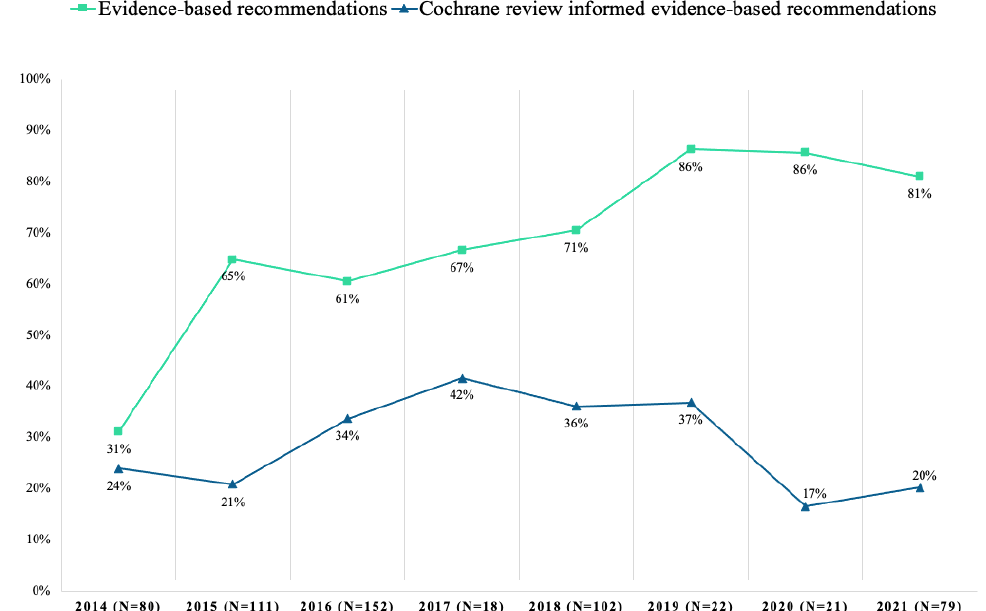
Figure 1. Evidence-based recommendations with outcomes informed by evidence from Cochrane reviews in Danish National Clinical Guideline development from 2014 – 2021.